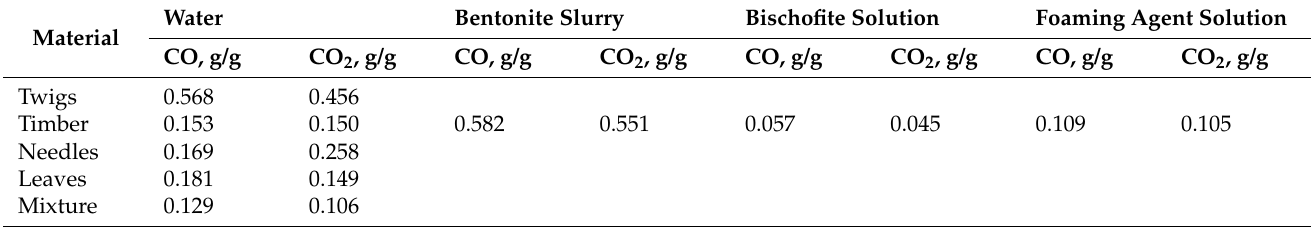
Table 7. Yields of pyrolysis and combustion products of forest fuel extinguished with fire extinguishing